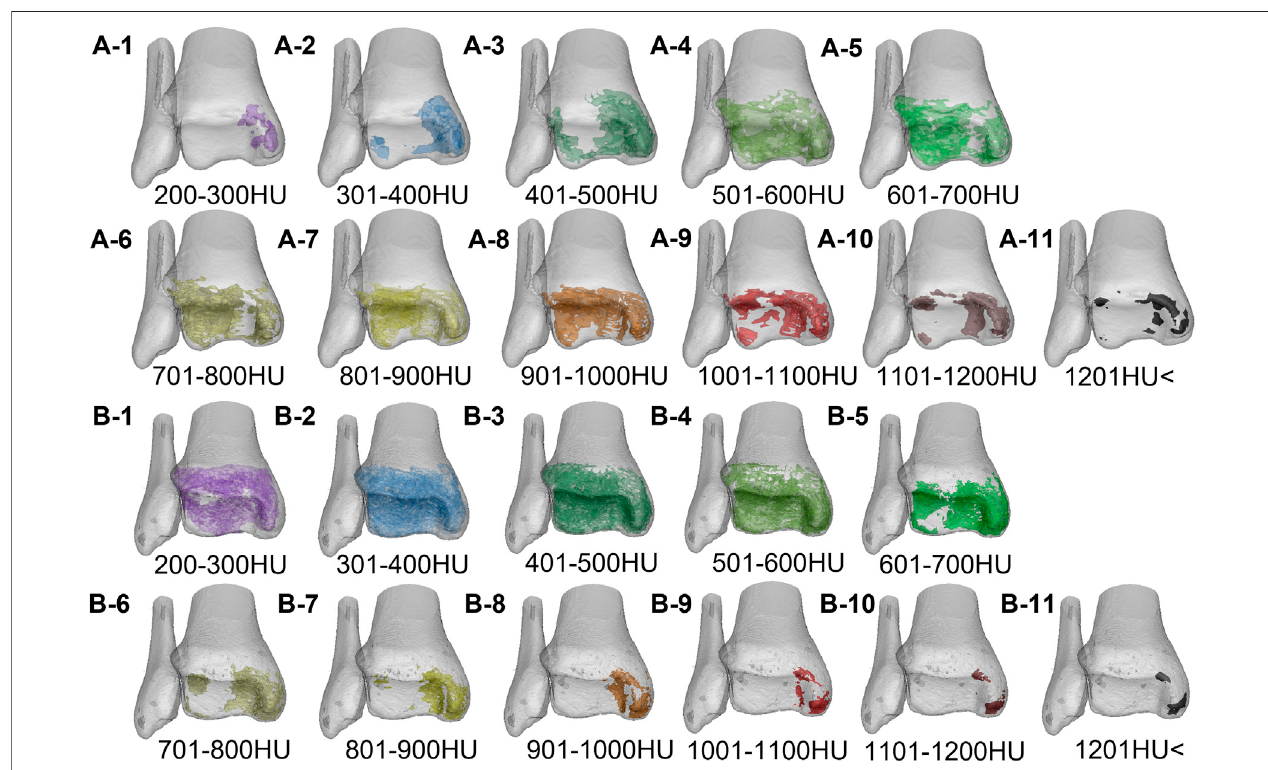
FIGURE6| Thevolumedistributionofbonetissuewithdifferentbonedensitiesinthedistaltibiaofthetwogroups.A1 – A11istheTaekwondogroup;B1 – B11isthe control group.